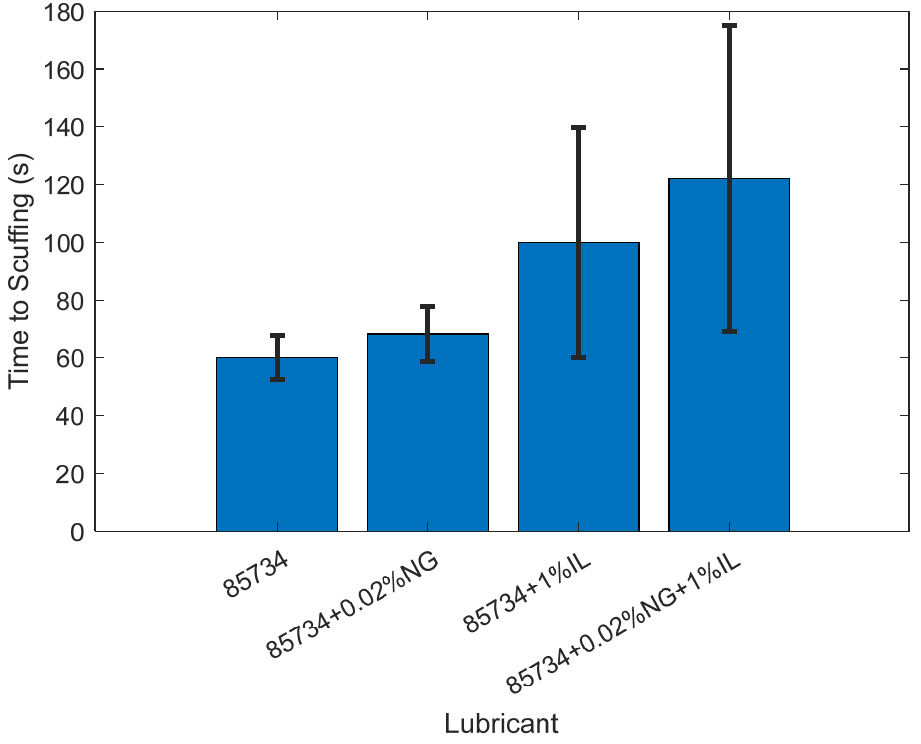
Figure 3. Average time to initiation of scuffing after shutting off oil supply in ball-on-disk, loss-of- Figure3. Averagetimetoinitiationofscuffingaftershuttingoffoilsupplyinball-on-disk,loss-of-lubrication lubrication experiments. Error with 95% confidence interval. experiments. Error with 95% confidence